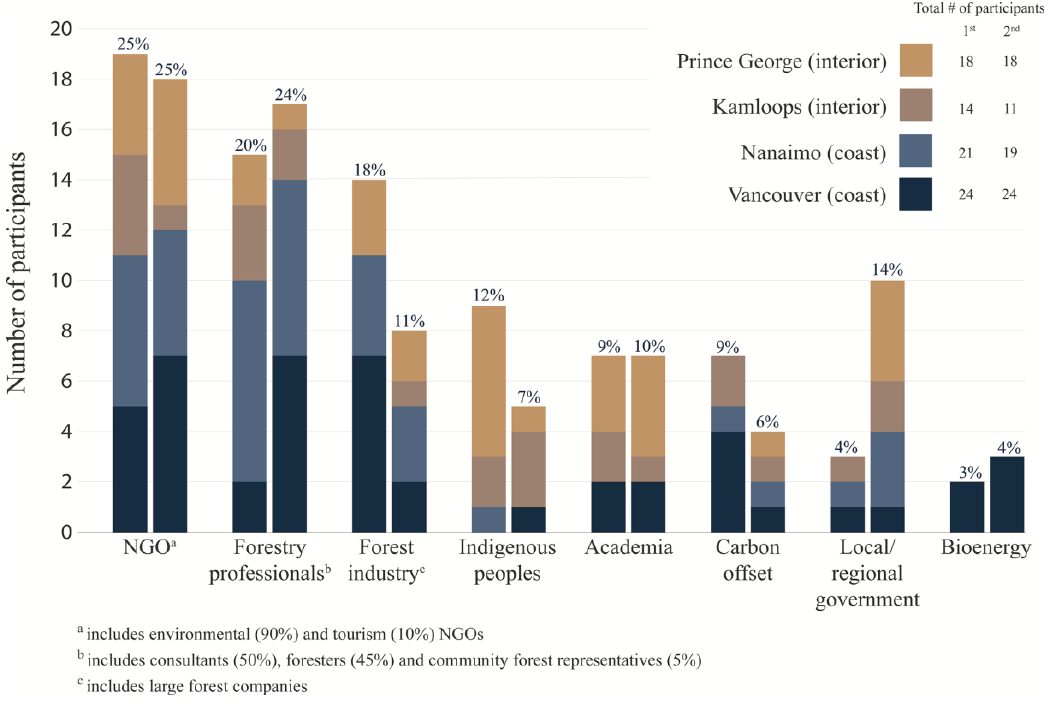
Figure 3. Representation (number of participants) by region of different groups of actors during the two series of participatory workshops: 1st round February – March 2016, 2nd round May – June 2017. Percent of total participants for each group and total number of participants at each series of workshops is also shown.